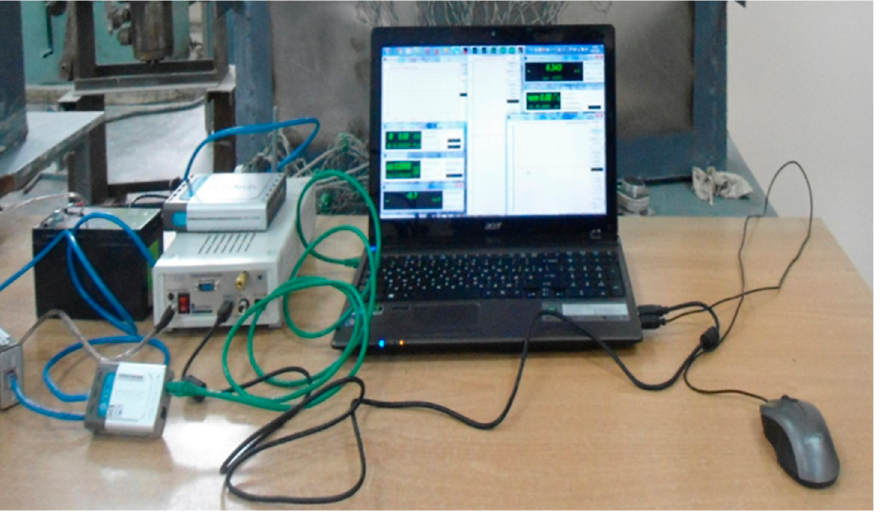
Figure 3. Strain gauge station, ZET